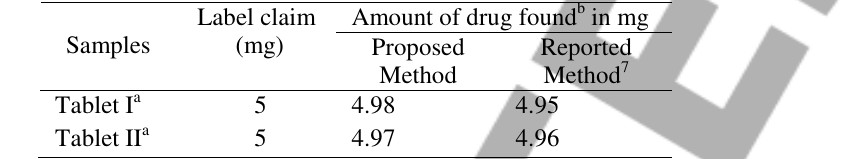
Amount of drug found b in mg